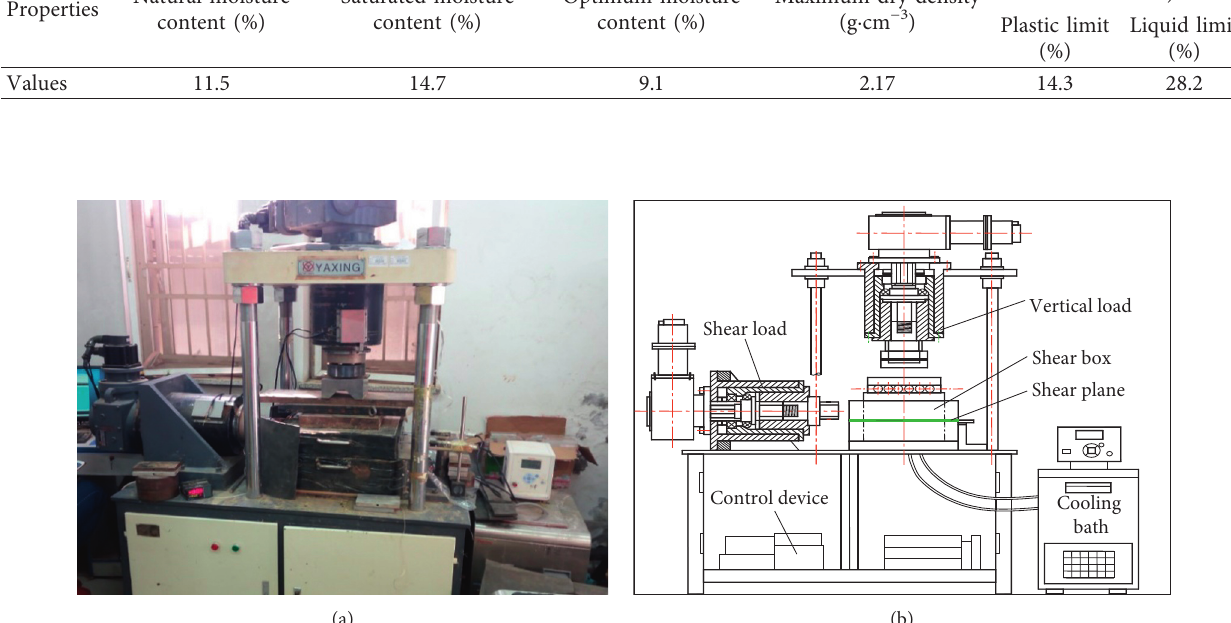
Figure 3: The large-scale direct shear test system (TZJ-150). (a) The test apparatus picture. (b) The test structural diagram.